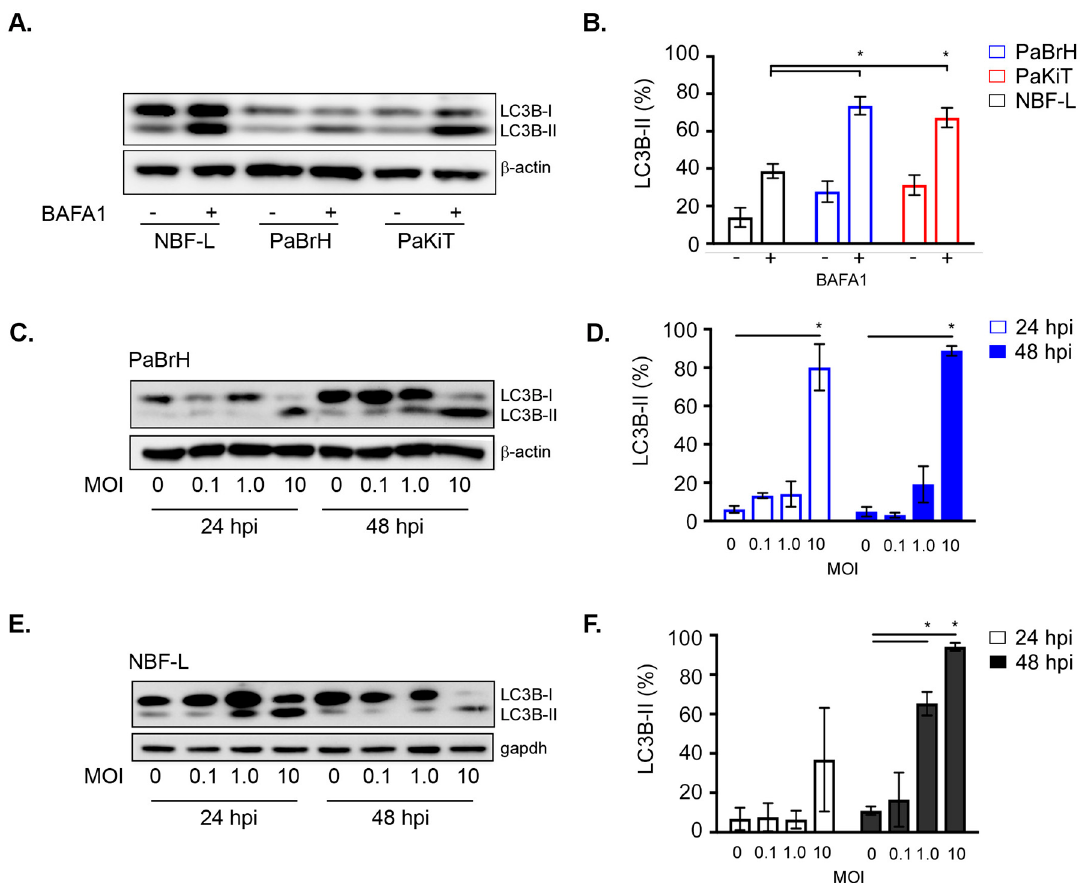
Figure 3. ABLV infection activates autophagy. ( A ) LC3B western blot of lysates from human NBF-L and black flying fox PaBrH and PaKiT cells, treated with BAFA1 (400 nM; 2 h). ( B ) LC3B-II ( β -actin-normalized) from BAFA1 treated cells. ( C ) LC3B western blot of lysates from PaBrH cell lysates. PaBrH cells were infected for times (hpi) and MOI indicated. ( D ) LC3B-II ( β -actin-normalized) expressed as a percentage of total LC3B from PaBrH cells infected with rABLV-GFP. ( E ) LC3B western blot of lysates from NBF-L cells infected with rABLV-GFP. ( F ) LC3B-II (gapdh-normalized) from NBF-L cells infected with rABLV-GFP. PaBrH and NBF-L cells were infected with rABLV-GFP for times (hpi) and MOI indicated. All data are a representative of three independent experiments, LC3B-II is expressed as a percentage of total LC3B, mean ± SEM, * p < 0.05, student’s t -test.